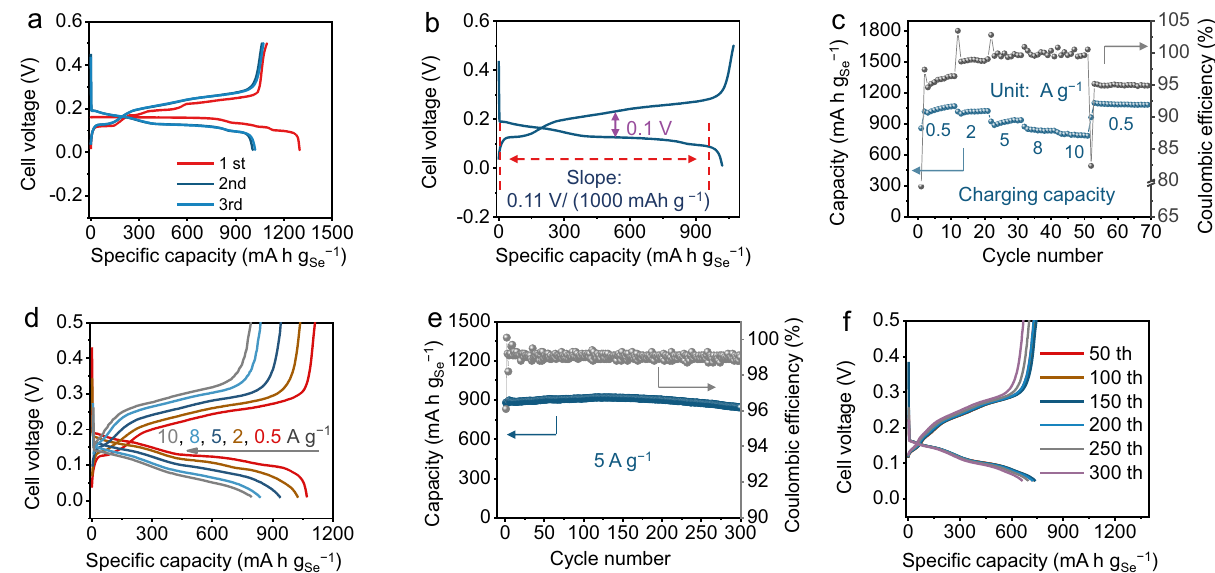
Fig. 2 Electrochemical characterization of the Cu|0.5 M CuSO 4 |Se@C-48 coin cells. a GCD curves of the fi rst three cycles of Cu||Se@C-48 cell (the number represents the Se content) at 0.5 A g − 1 . b The discharging plateau and polarization between discharging and charging curves of Cu||Se@C-48 cell at 1 A g − 1 . c Rate performance, d corresponding GCD curves, e cycling stability test (5 A g − 1 ), and f GCD curves at different cycles of the Cu||Se@C-48